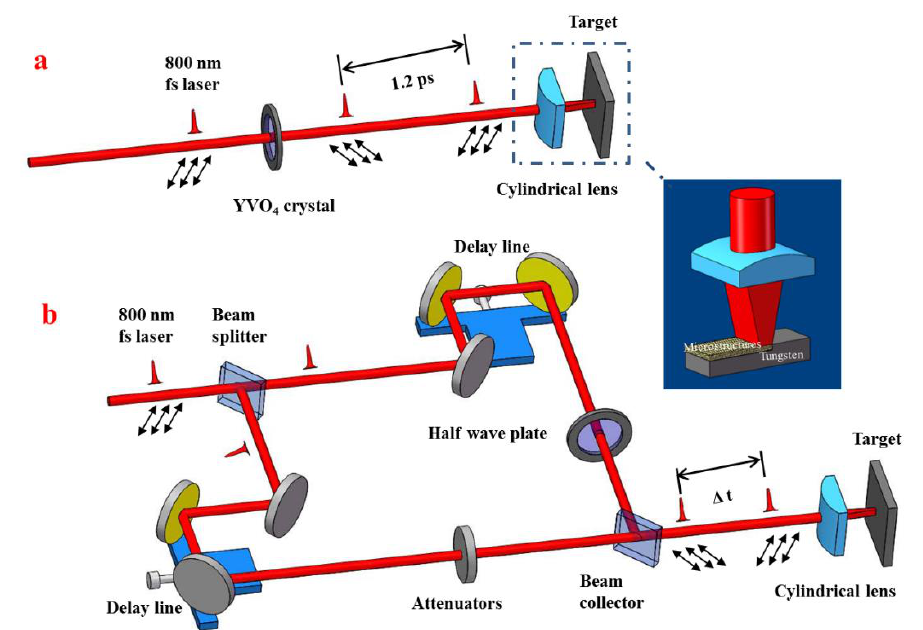
Figure 1. This two schematic diagrams for the formation of 2D subwavelength periodic triangular structures on tungsten surfaces using two time-delayed femtosecond laser beams with orthogonal polarizations. ( a ) generation of two femtosecond laser beams with a fixed time delay of 1.2 ps via a birefringent crystal; ( b ) generation of two femtosecond laser beams with tunable time delays based on an interferometric configuration. The double arrows represent directions of the linear polarization of femtosecond laser beams.